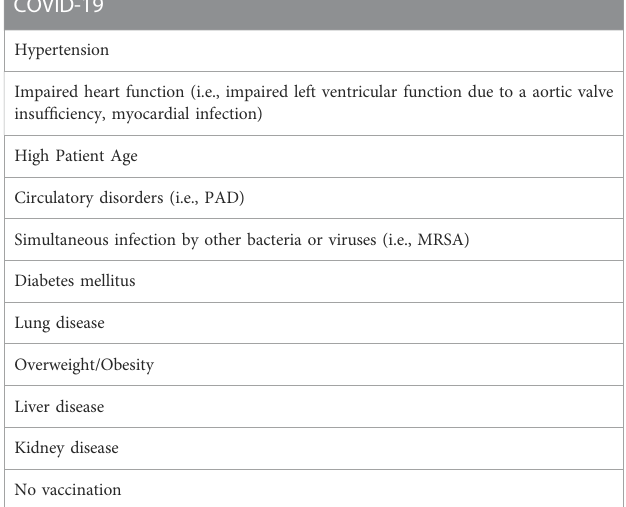
TABLE 1 Risk factors for a severe course of COVID-19. PAD: Peripheral artery disease; MRSA: Methicillin resistant Staphylococcus aureus (Kaniusas et al., 2020; Dayaramani et al., 2021; Hu et al., 2021; Luo et al., 2021). Diseases leading to a higher risk factor for a severe course of